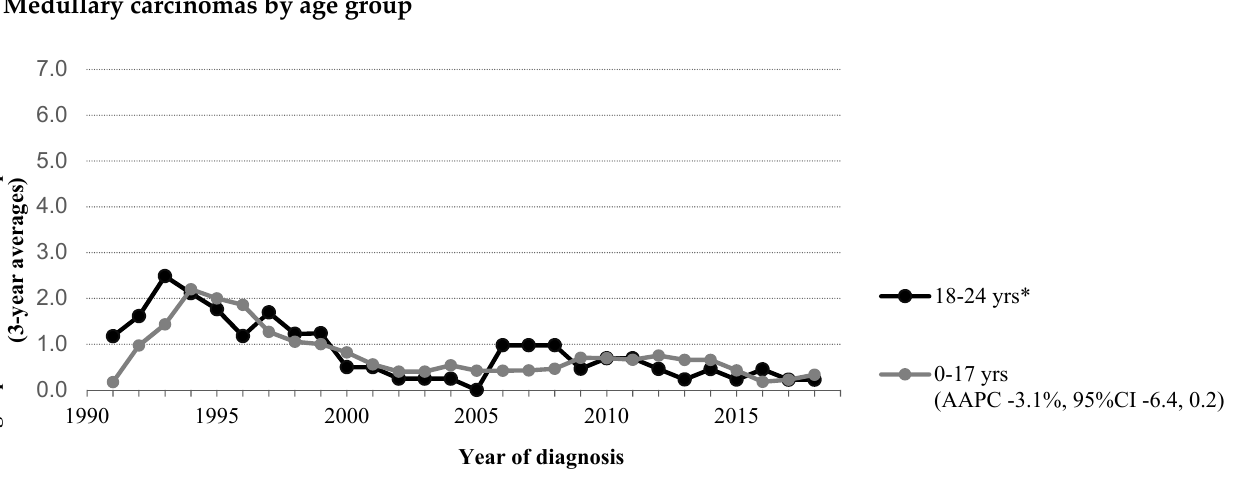
Figure 2. Time trends in incidence of patients aged 0–24 years with thyroid carcinoma by histology and age in The Netherlands, 1990–2019. ( A ) Papillary thyroid carcinoma. ( B ) Follicular thyroid carcinoma. ( C ) Medullary thyroid carcinoma. Abbreviations: AAPC, Average Annual Percent Change; CI, Confidence Interval. Three-year moving averages of the age-specific incidence rate of thyroid carcinoma are shown. The incidence rates of the patients 0–9 and 0–17 years are age- standardized according to the World Standard Population. AAPC was estimated from a regression line, which was fitted to the natural logarithm of the rates using year of diagnosis as a regressor variable. * Estimation of a reliable average annual percentage change was not possible because of n = 0 in >5 incidence years.